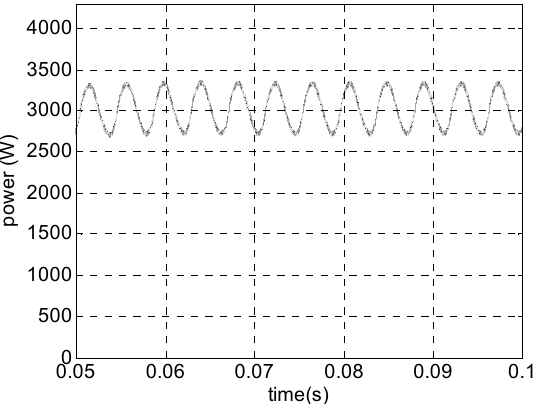
Figure 3. Generator’s active